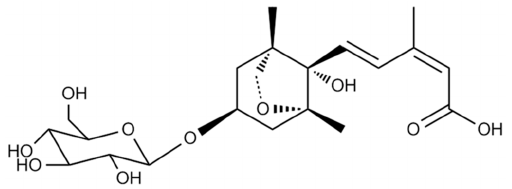
Figure 1. Chemical structure of the isolated (1 ′ R ,2 ′ S ,5 ′ R ,8 ′ S ,2 ′ Z ,4 ′ E )-dihydrophaseic acid 3 ′ - O - β - D - glucopyranoside (DPA3G).